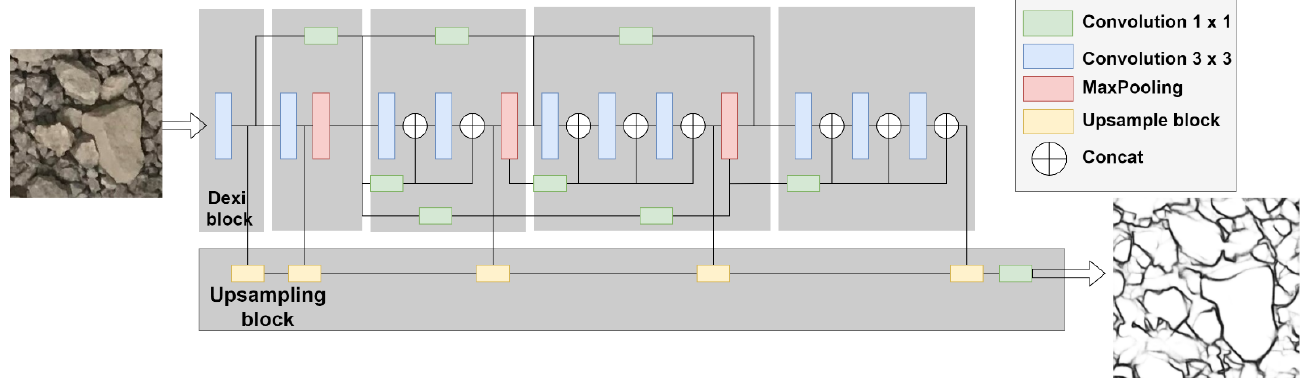
Figure 3. The network structure of DexiNed-based edge prediction model.